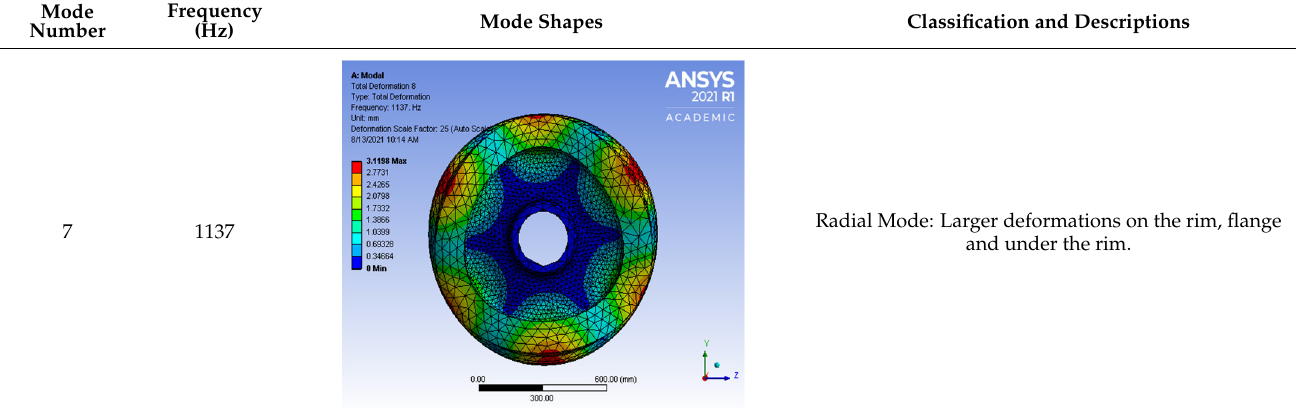
Radial Mode: Larger deformations on the rim, flange and under the rim.